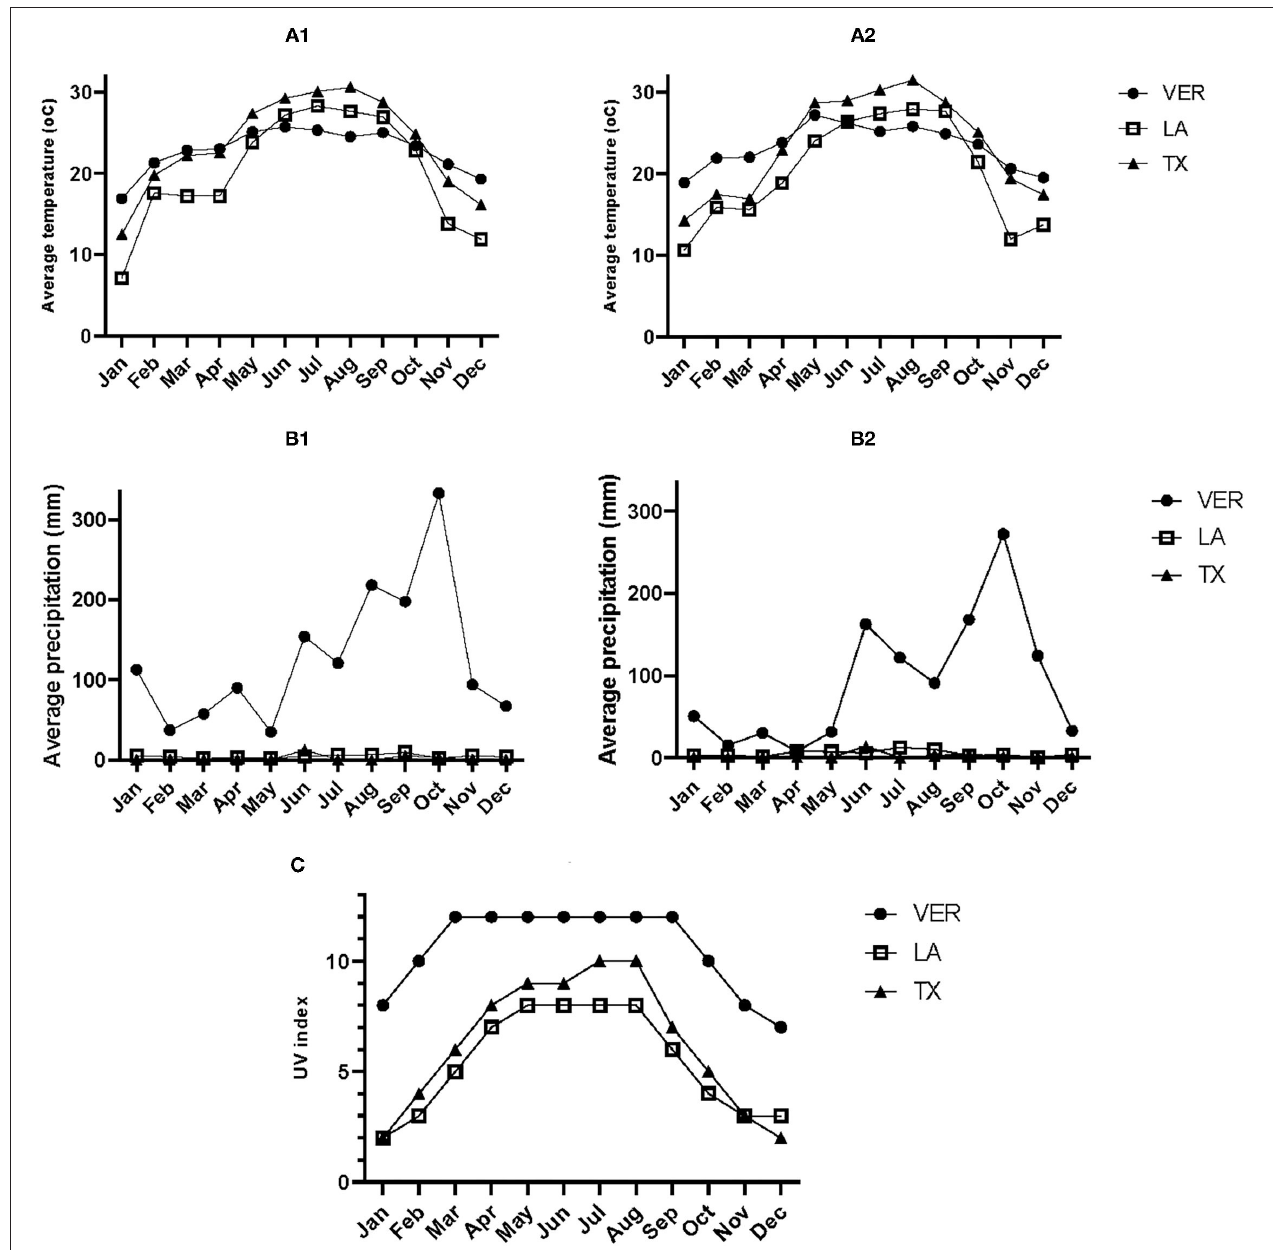
FIGURE 3 | (A1) Temperature (oC) in 2018, (A2) temperature (oC) in 2019, (B1) precipitation (mm) in 2018, (B2) precipitation (mm) in 2019, (C) UV index in 2019. Records registered in three different locations of sugarcane production. VER: Mahuixtlan, Ver; MX, LA: St. Mary, LA, US.; TX: Santa Rosa, TX, US.